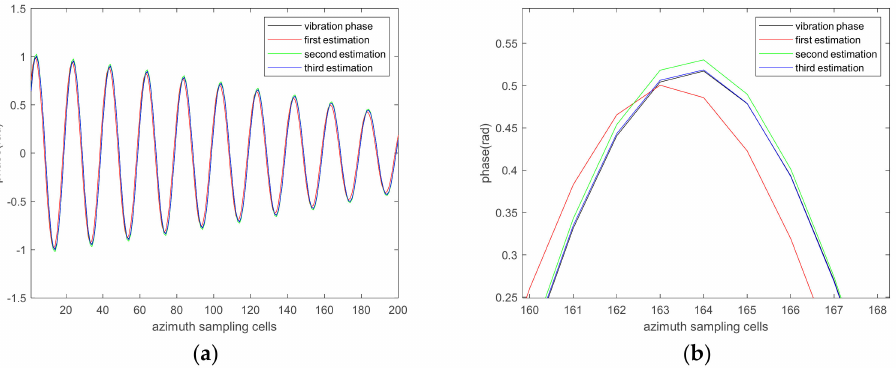
Figure 14. ( a ) Vibration phase and its estimated value under condition 3. ( b ) Partial enlargement of (a).